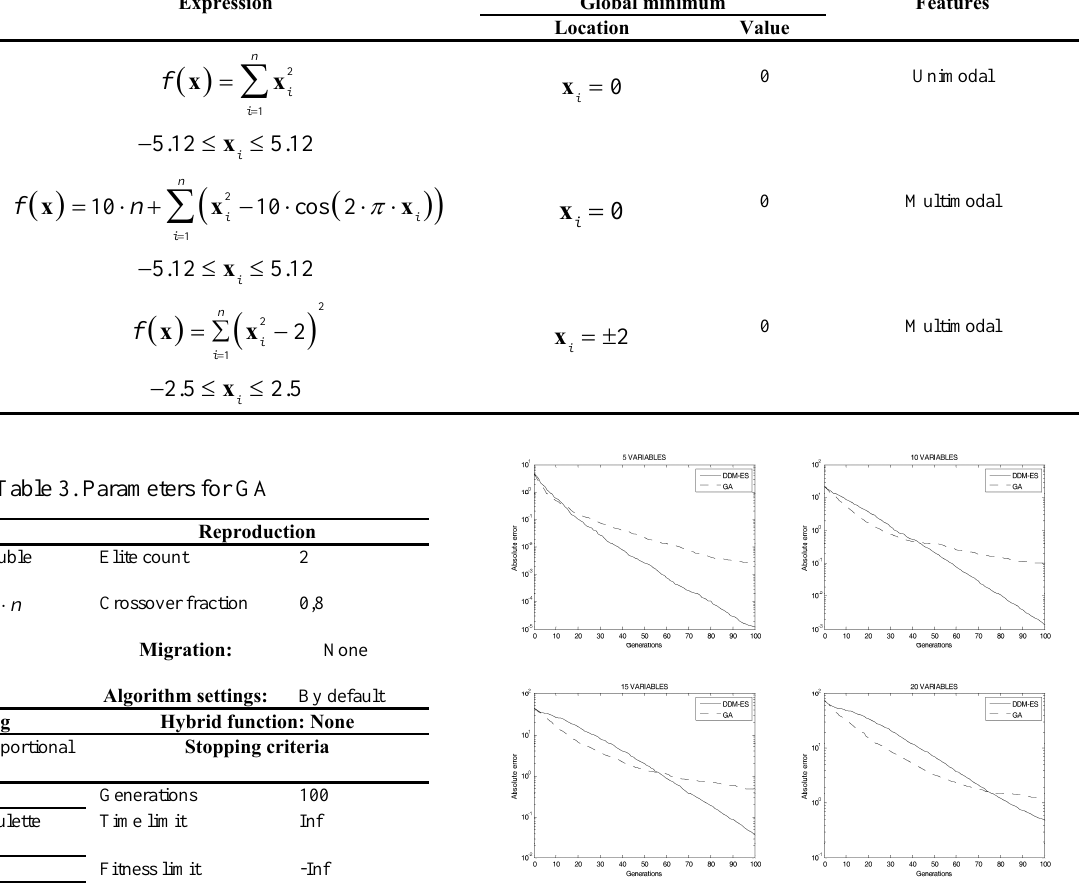
Fig. 4 Outcomes of Hyper-sphere function